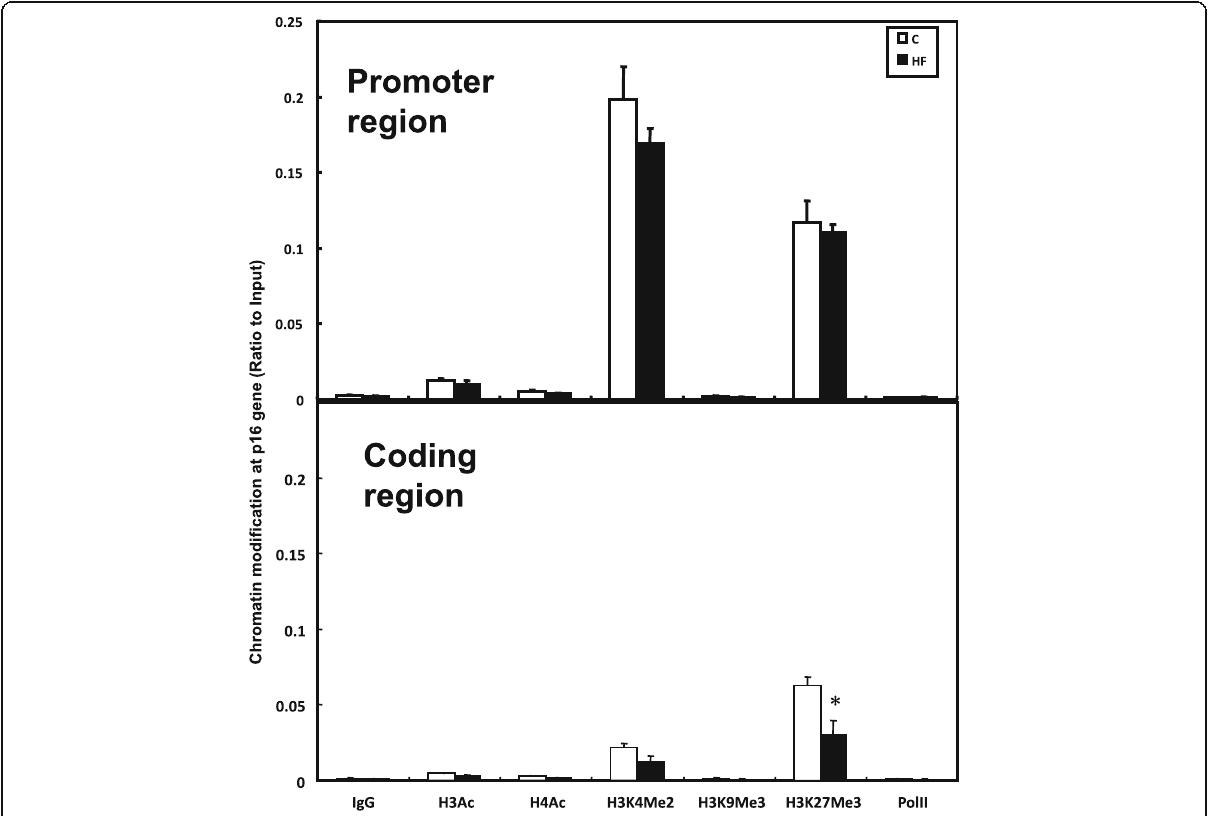
Fig. 5 Chromatin modification at coding region and promoter region in p16(INK4a) gene in livers of rats fed C and HF diets respectively. Chromatin modification on p16(INK4a) gene at different regions in HF ( n = 10) and C ( n = 10) rats as determined by chromatin immunoprecipitation (ChIP) assay. Data are presented in arbitrary units as relative DNA abundance normalized to DNA of input abundance. Values are means ± SEM, P <